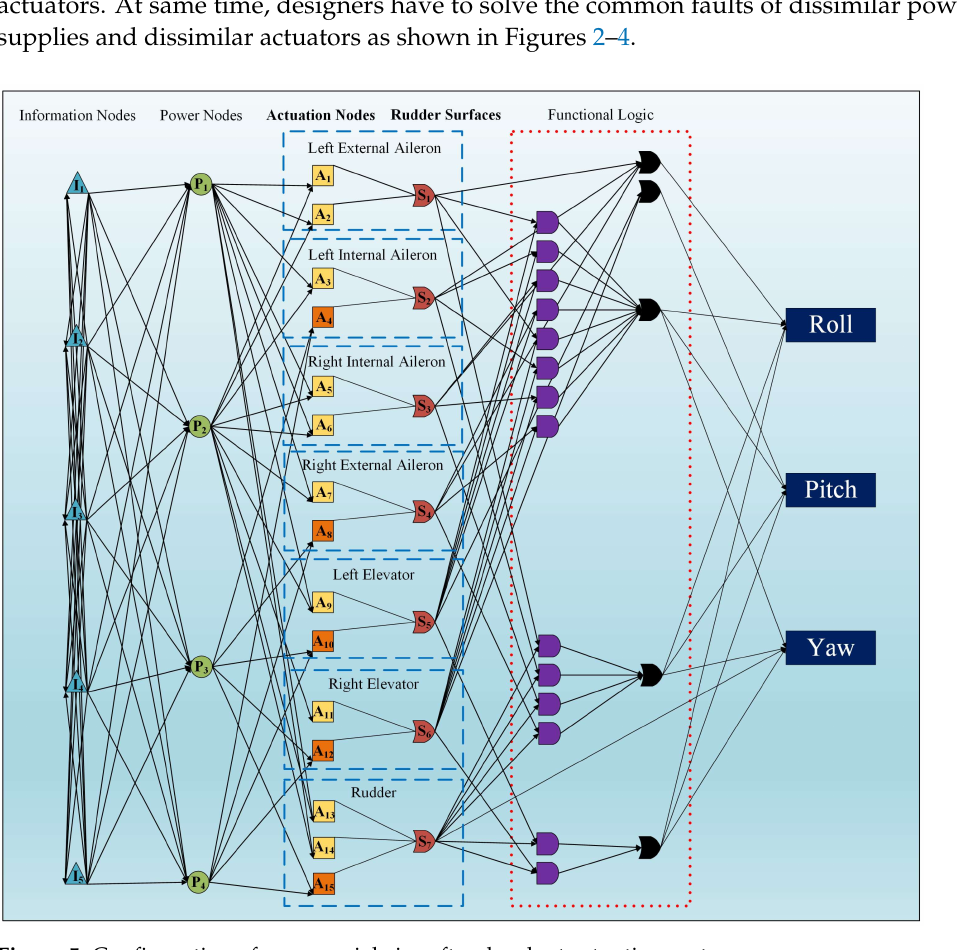
Figure 5. Configuration of commercial aircraft redundant actuation